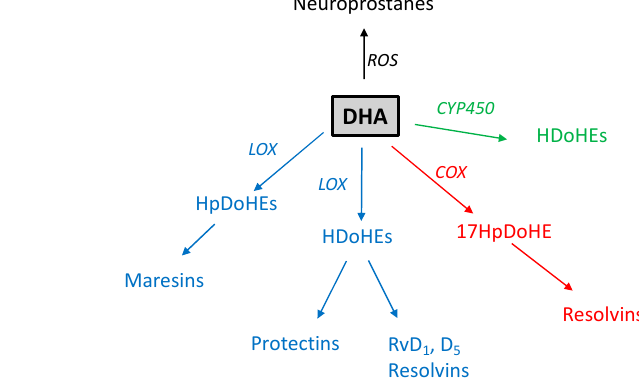
Figure 1. The biosynthesis of AA- and DHA-derived active lipids in trypanosomatids. LOX enzymes are in blue, COX enzymes in red, and CYP450 enzymes in green. Arachidonic acid (AA) can be metabolized into thromboxanes and prostaglandins by the COX pathway; into hydroxyeicosatetraenoic acid (HETEs), leukotrienes, oxoeicosatrienoic acids (oxoETES), dihydroxyeicosatetraenoic acid (diHETEs) via the LOX pathway; into HETEs, epoxyeicosatrienoic acids (EETs), dihydroxyeicosatrienoic acid (diHETrEs) via CYP450. Docosahexaenoic acid (DHA) can be metabolized into hydroxydocosahexaenoic acids (HDoHEs), D-resolvins (RvD1; RvD2), maresins, protectins via the LOX pathway, and hydroxydocosahexaenoic acid (HDoHEs) via the CYP pathway. 17-hydroperoxydocosahexaenoic acid (17-H(p)DoHE) issued from the COX pathway is the precursor of DHA-derived specialized proresolving mediators.